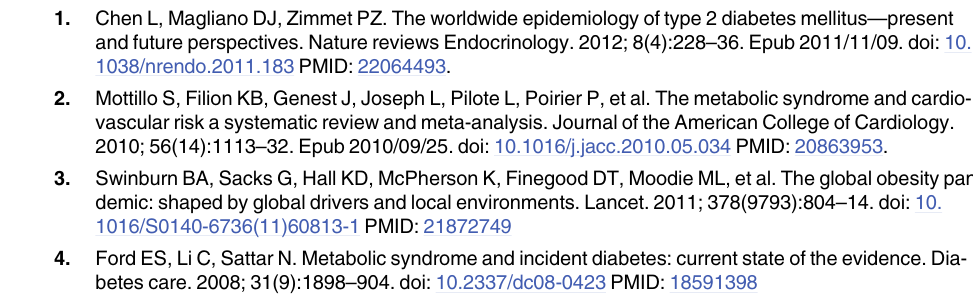
S1 Dataset. Raw data and statistics. Individual data and statistics for Figs 1 – 7 and Table 2. dividual data and statistics for Figs 1 – 7 and Table